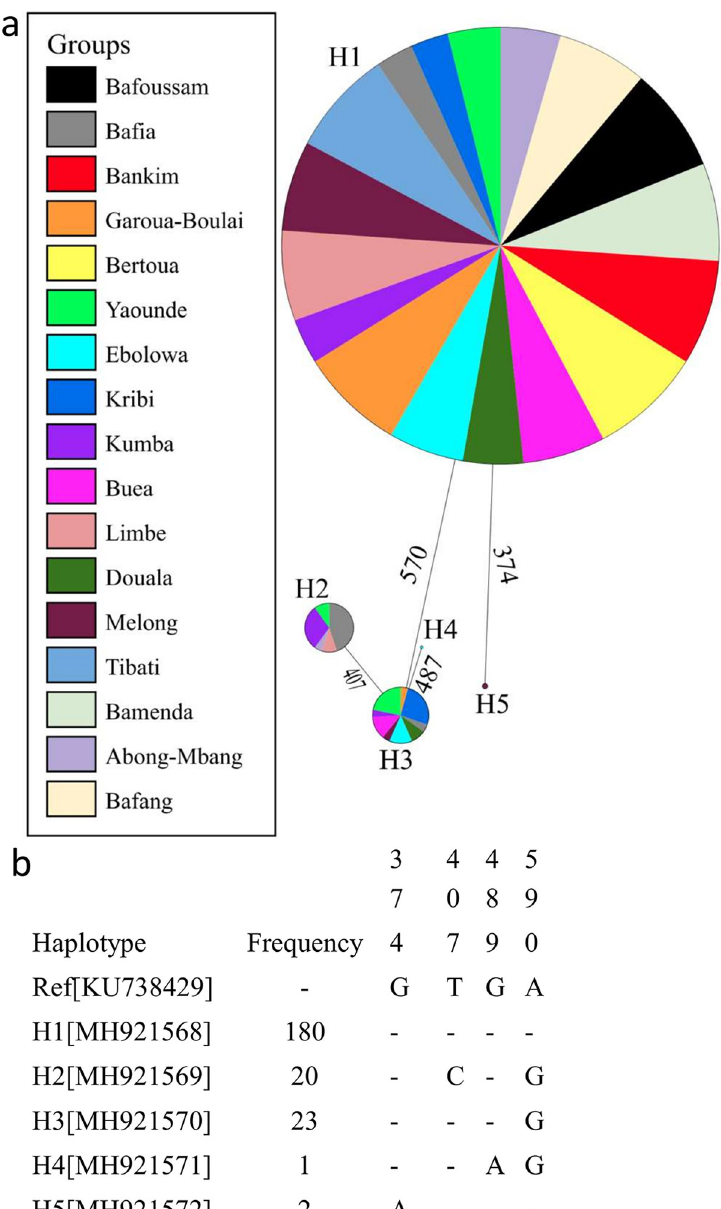
Fig 2. Genetic diversity of the COI gene across Cameroonian populations of Ae . albopictus . a, Haplotype network showing the genealogic relationship between five haplotypes detected across Cameroon. b, COI haplotypes found across Cameroon. Only polymorphic positions are shown and are numbered with reference (Ref) to the published Ae . albopictus sequences for COI (JF309317; China). Dots represent identity with respect to the